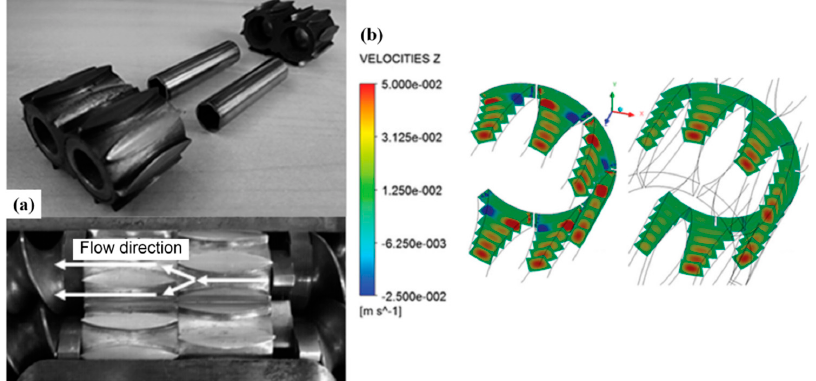
Figure 2. ( a ) Structure of the extensional mixing element (EME) and flow direction in two EMEs in series. ( b ) Velocity profiles for two EME in series. Reproduced with permission from [18]. Copyright 2015, John Wiley and Sons.